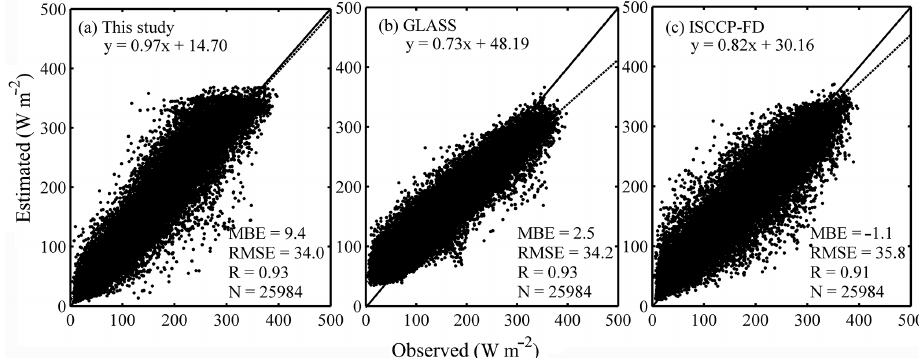
Figure 10. Comparison between the observed and the estimated daily SSR at all CMA radiation stations in 2009 for (a) this study, (b) GLASS, and (c) ISCCP-FD. Units of MBE and RMSE are Wm − 2